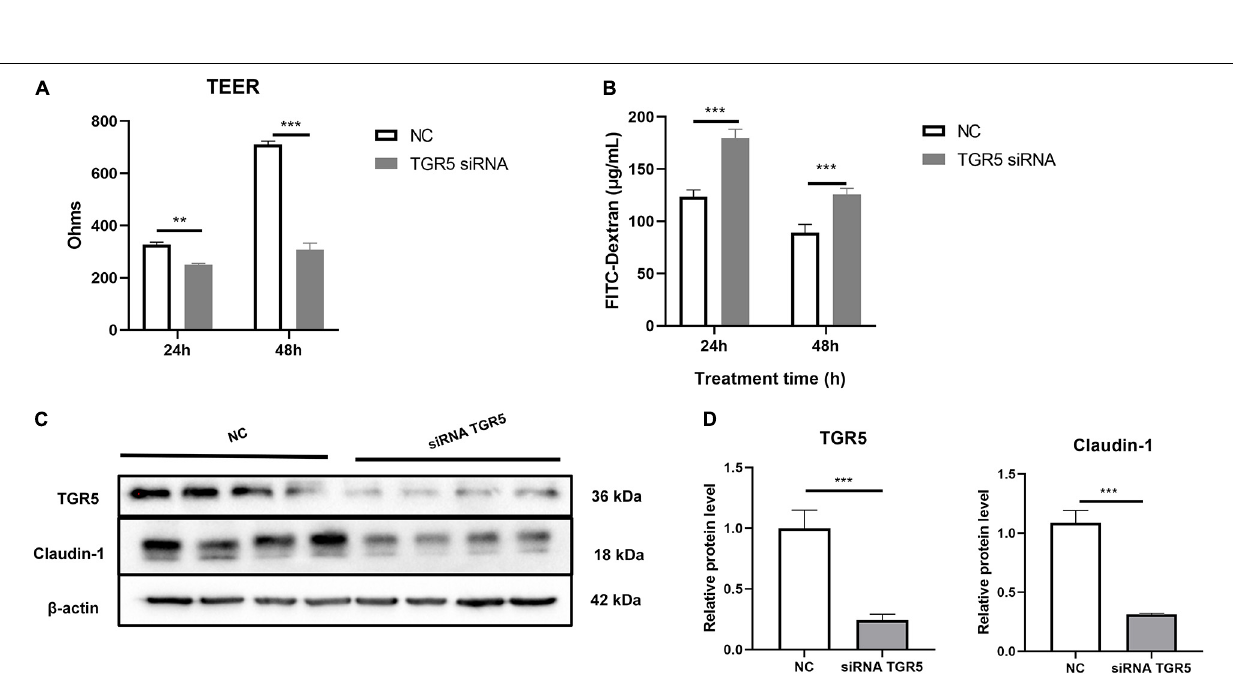
Frontiers in Microbiology |